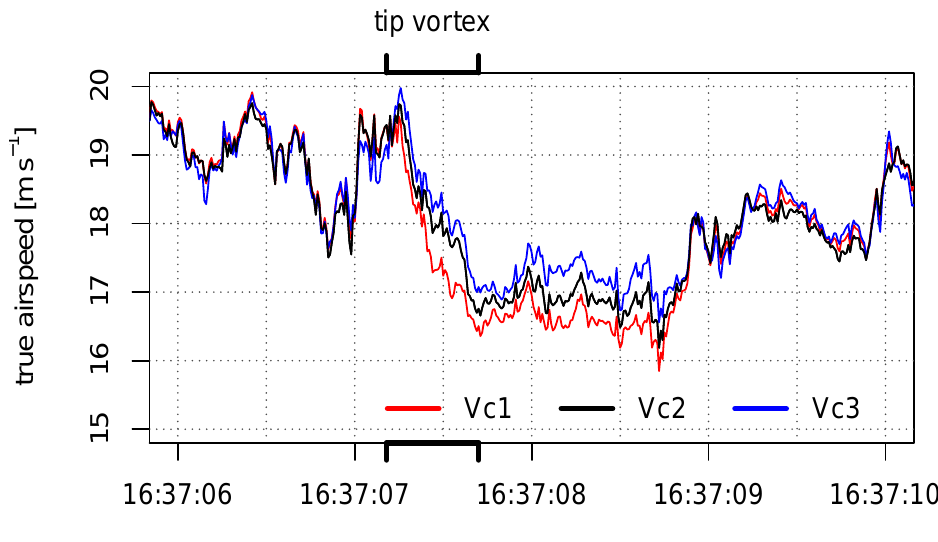
Figure 17. Fraction of the time series of the true airspeed | (cid:126) u a | . The data is plotted for the three calibrations at v c 1 , v c 2 and v c 3 . The position of the tip vortex is